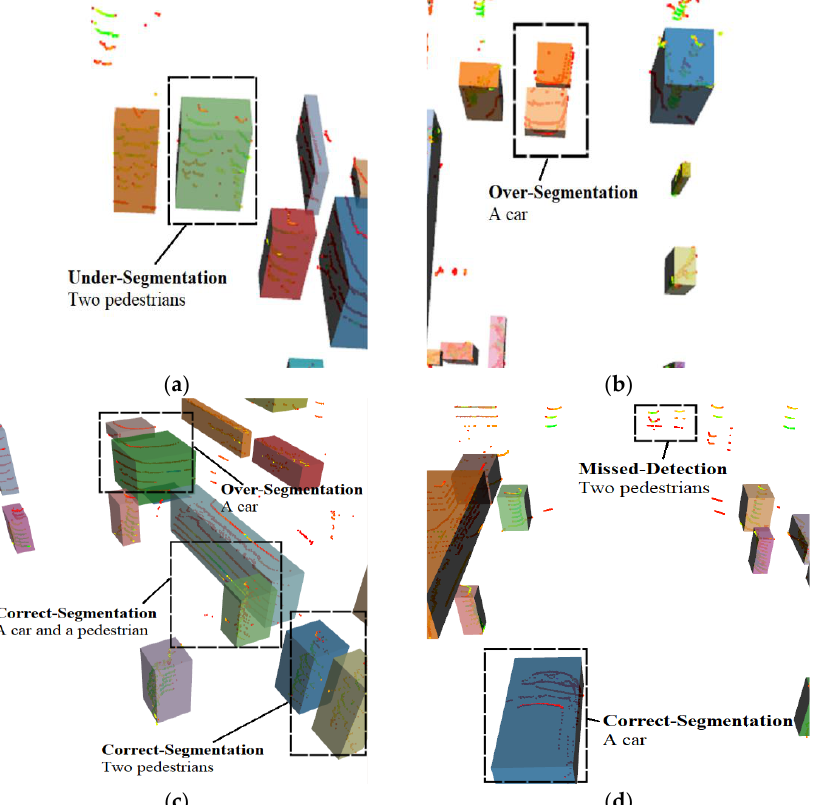
Figure 7. Wrong point cloud segmentation results using fixed clustering threshold: ( a ) the point cloud of the two pedestrians is under-segmented; ( b ) the point cloud of the car is over-segmented; ( c ) the point cloud of the pedestrians is accurately segmented, and the point cloud of the car is over-segmented; ( d ) the point cloud of the car is accurately segmented, and the two pedestrians are not detected.